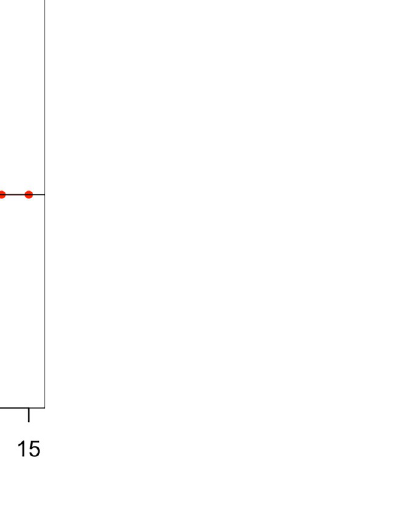
Fig 3. The evolution of the states of the system given by the differential equation in (1) starting with x 0 = -0.5.